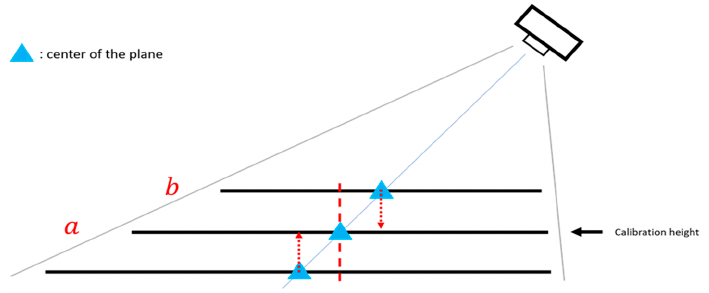
Figure 9. Errors caused by different heights.